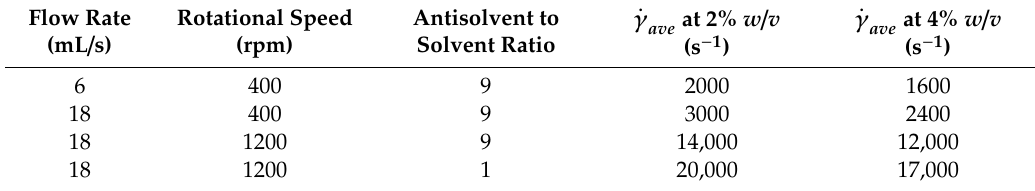
Figure 6. Local shear rate along the radial distance of the SDR. Table 2. Average shear rates across the disc, (s − 1 ), to 2 significant figures, at selected conditions displayed in Figure 6.